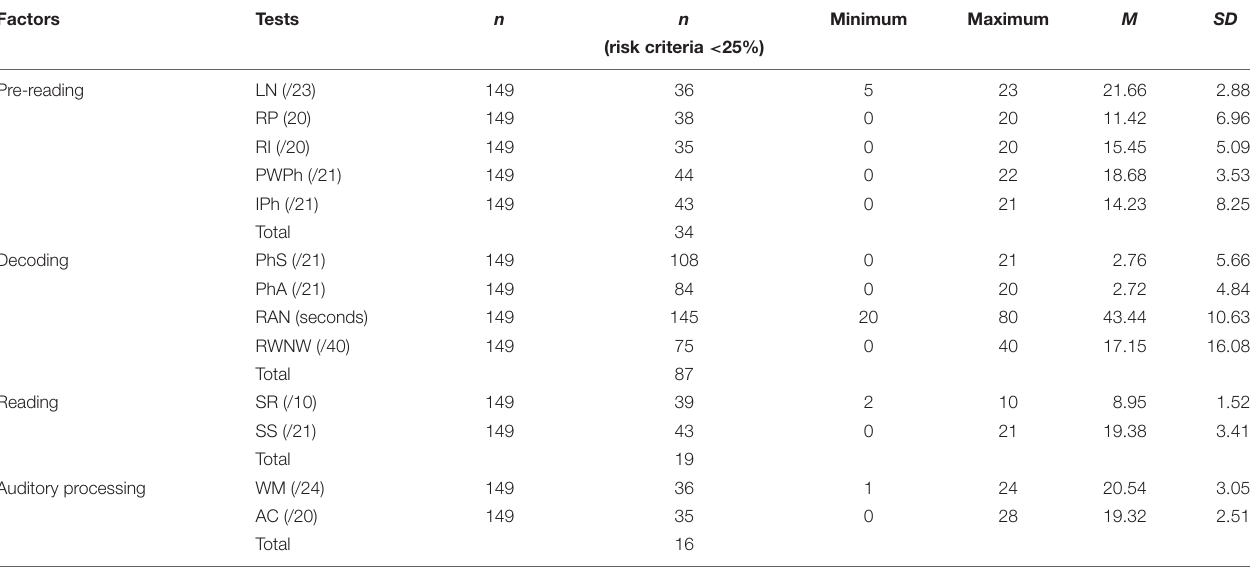
TABLE 5 | Distribution of the factors according to the risk criteria (performance below the 25th